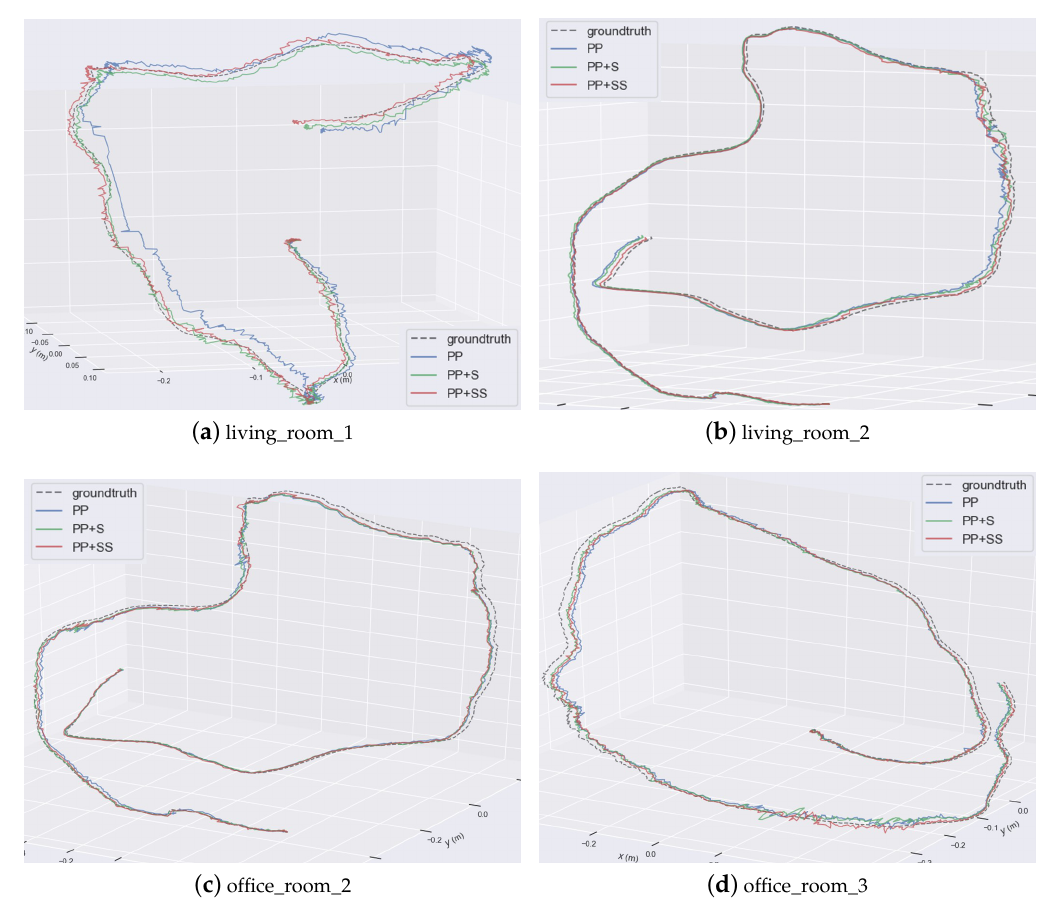
Figure 7. Comparison of estimated trajectories. Different trajectories are plotted